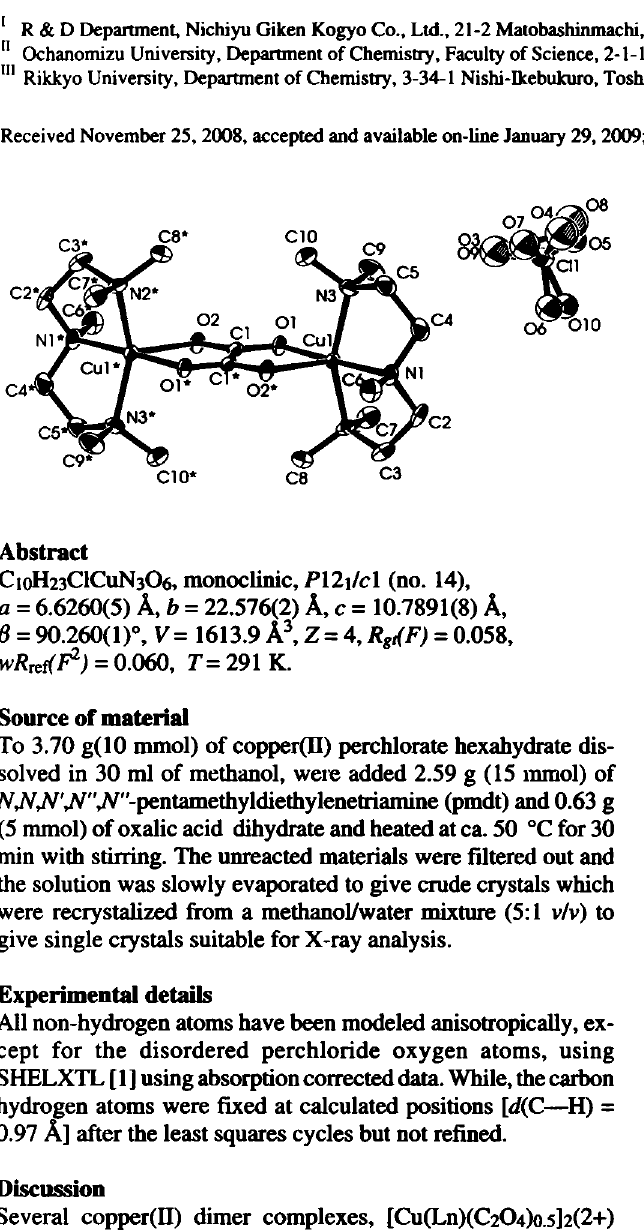
Table 2. Atomic coordinates and displacement parameters (in Â 2